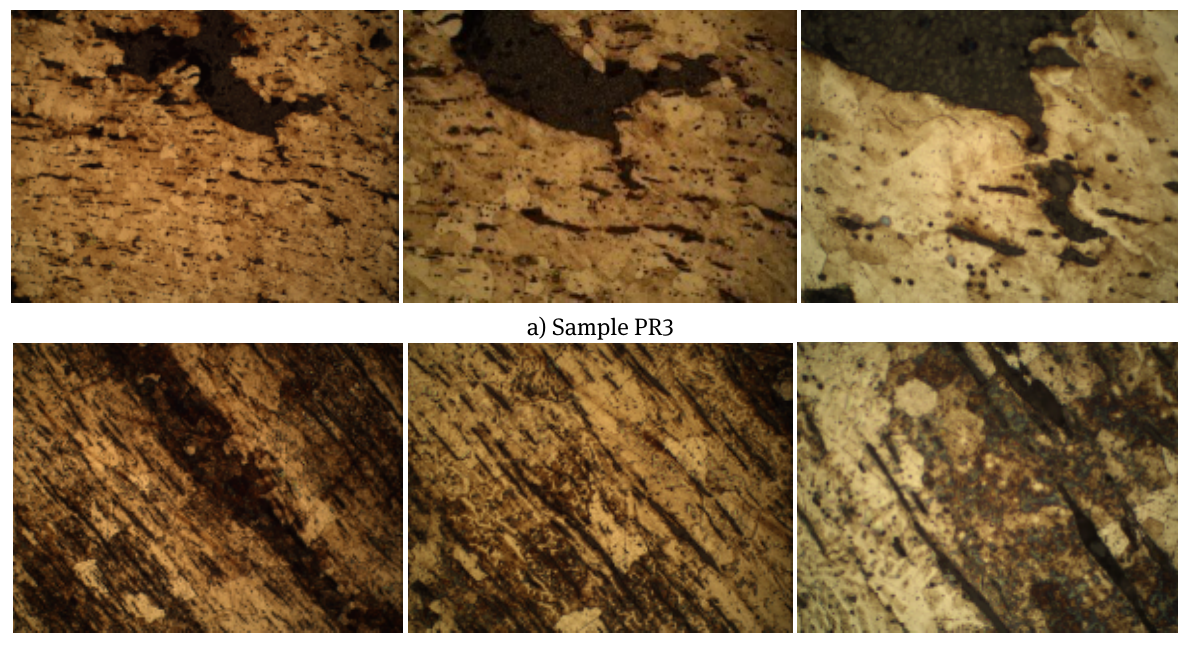
Figure 6: Images showing surface microstructure of nail samples.